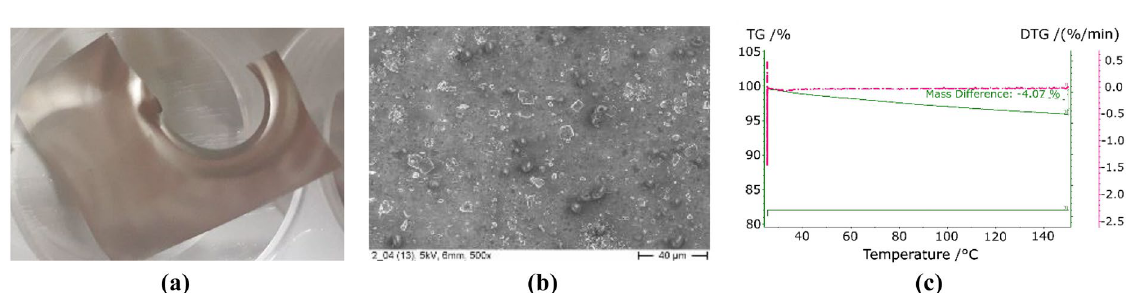
Figure 4. Eloxal with CaCl 2 : real view ( a ), SEM ( b ), and TGA ( c ).